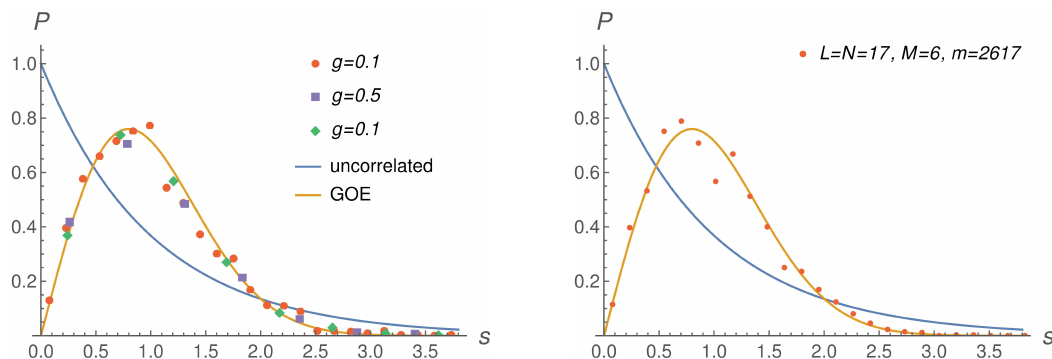
Figure 4: Distribution of spacings for the dilatation operator through two-loops for g = 0.1,0.5,1 (left) and for the two-loop part of the dilation operator by itself (right) in the su ( 2 ) sector. In both cases we focus on the positive parity sector of L = 17 states, and clip 11% and 4% of low- and high-energy states respectively.